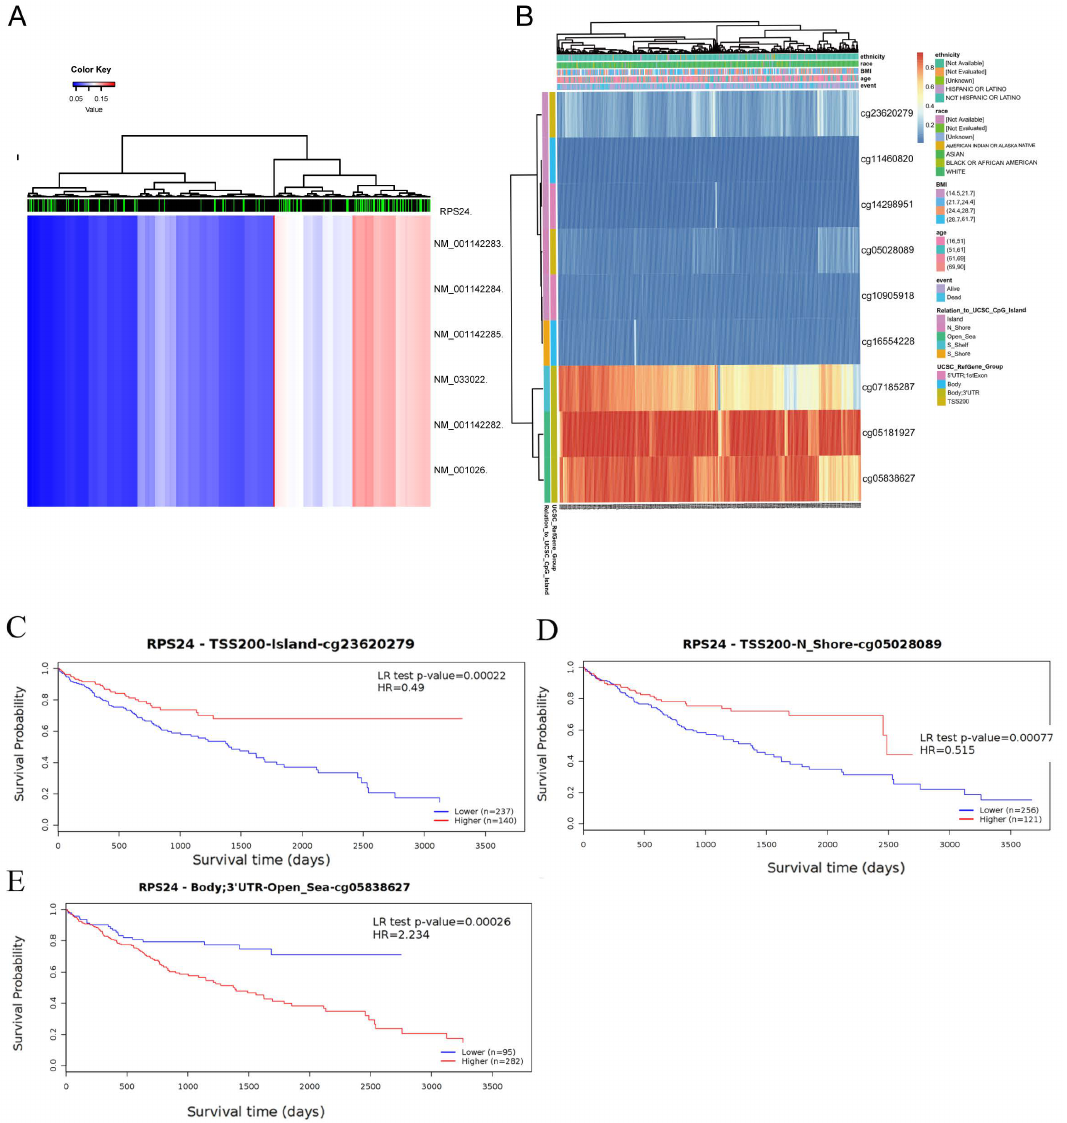
Figure 4. Methylation analyses of RPS24 expression in HCC. ( A ) We used the online DiseaseMeth database to compare the methylation levels of the RPS24 promoter in HCC cancer tissues and normal liver tissues. Each column represents a sample, with green representing normal samples and black representing tumor samples. The redder the heat map color is, the higher the methylation level is ( B ). Heatmap of methylation changes at multiple sites in the RPS24 DNA sequence, analyzed using the Methsurv database. ( C – E ) The relationship between methylation and prognosis at different loci: cg05028089 ( C ), cg05838627 ( D ), and cg23620279 ( E ).